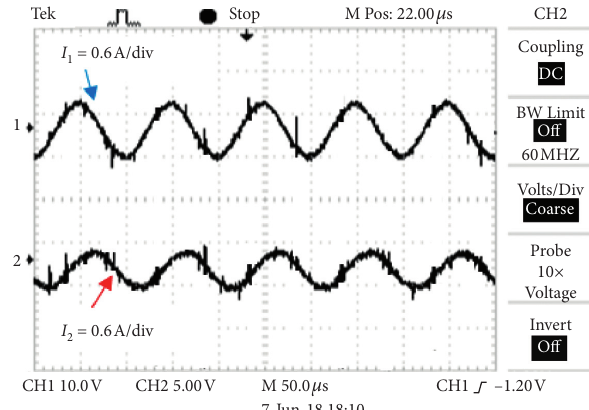
Figure 13: Input I 10cm air � 55 nF. (b) p